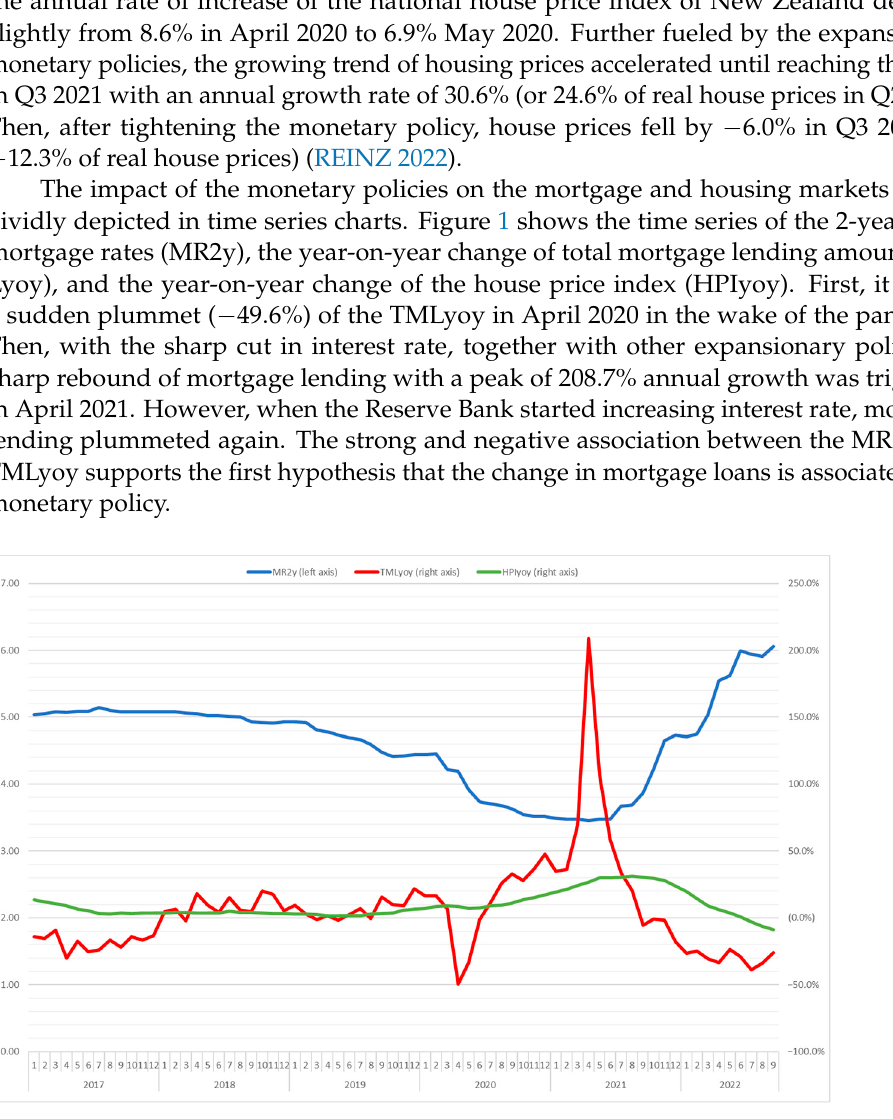
Figure 1. Two-year fixed mortgage rates (MR2y, left axis), year-on-year change of total mortgage lending (TMLyoy, right axis), and year-on-year change of the house price index (HPIyoy, right axis) of New Zealand, January 2017–September 2022. Sources: RBNZ (2022a, 2022b), REINZ (2022).